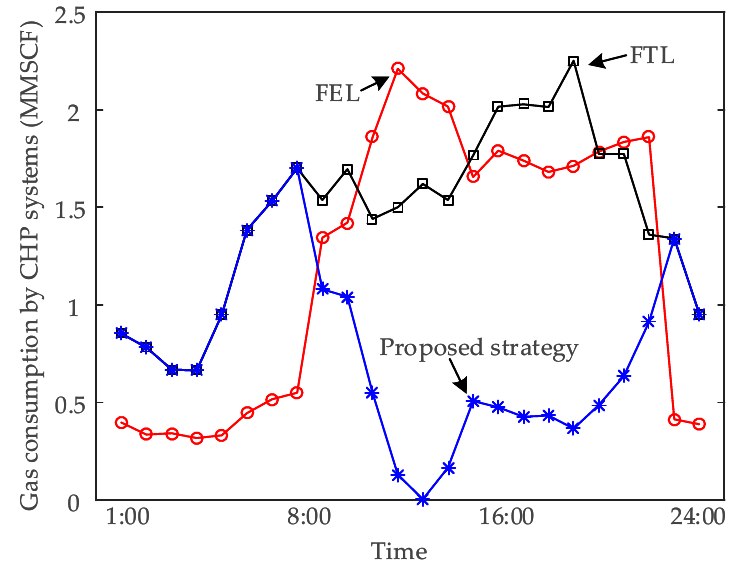
Figure 10. Gas consumptions following different control strategies (Winter, C = 0.55).